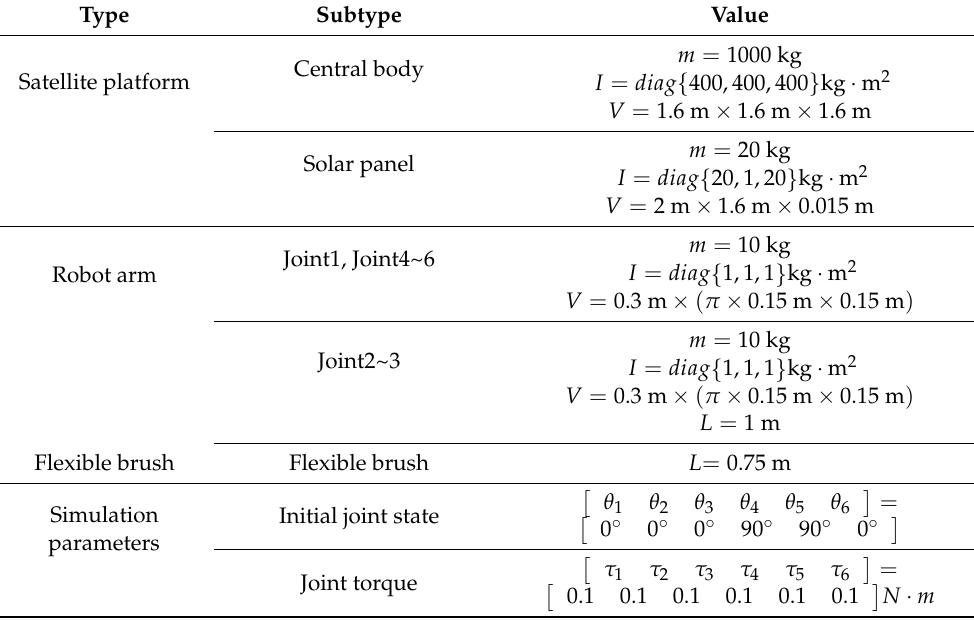
Table 4. List of simulation parameters of the space detumbling